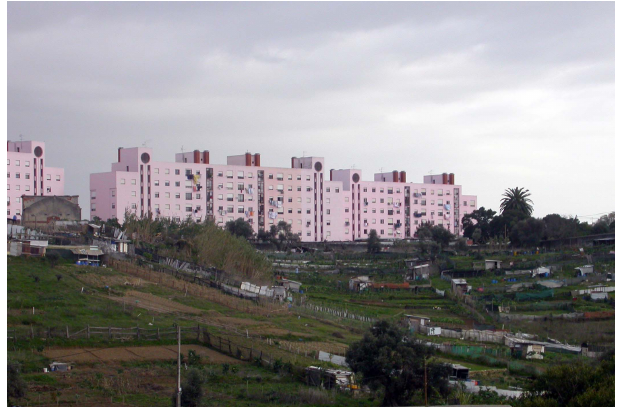
Figure 1. Community gardens in the north of Lisbon (Por- tugal).